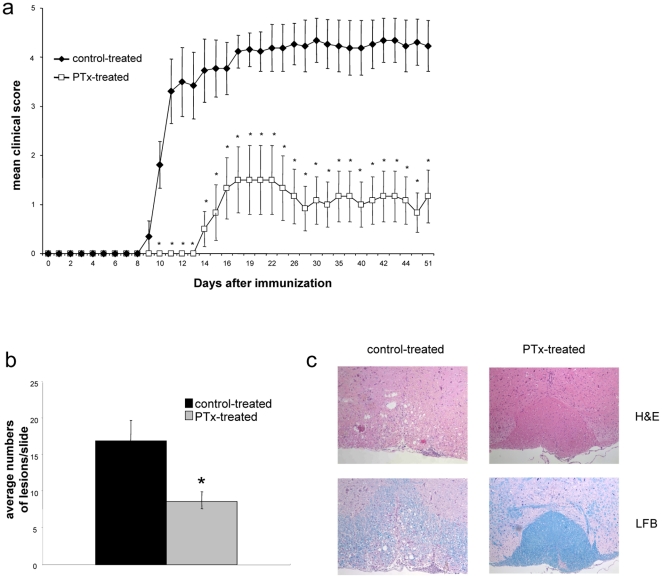
C57Bl/6 mice received weekly i.v. injections with 300 ng PTx in 200 ul of PBS or PBS alone.After six months of PTx injection, mice were immunized with MOG p35-55 in CFA and injected i.v. with 300 ng PTx in PBS immediately following the immunization and 48 h later. (a) Mice were followed for clinical signs of EAE (10 mice/group, mean severity is indicated as group average +/− SEM, * indicates p<0.05). (b+c) 50 days after EAE induction, CNS tissue from all mice was analysed for histological signs of EAE. Spinal cords were isolated and representative cervical, lumbal and thoracical sections were evaluated for inflammatory lesions. (b) Indicated is the average number of lesions per slide +/− SEM in each group (* indicates p<0.05). (c) Shown are representative slides stained with H&E (upper panels) or LFB (lower panels, magnification X100), (representative for two separate experiments).